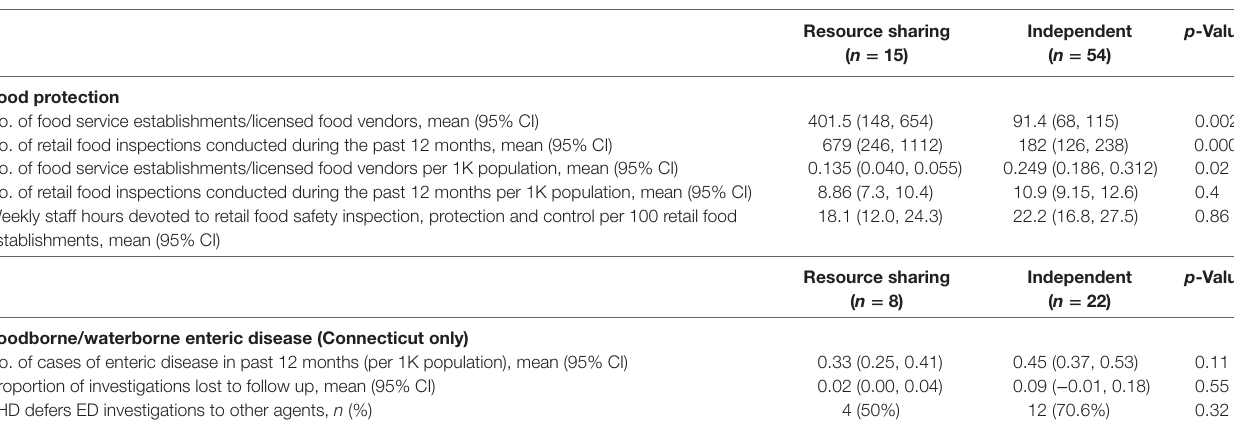
TaBle 7 | Food safety and enteric disease activities.